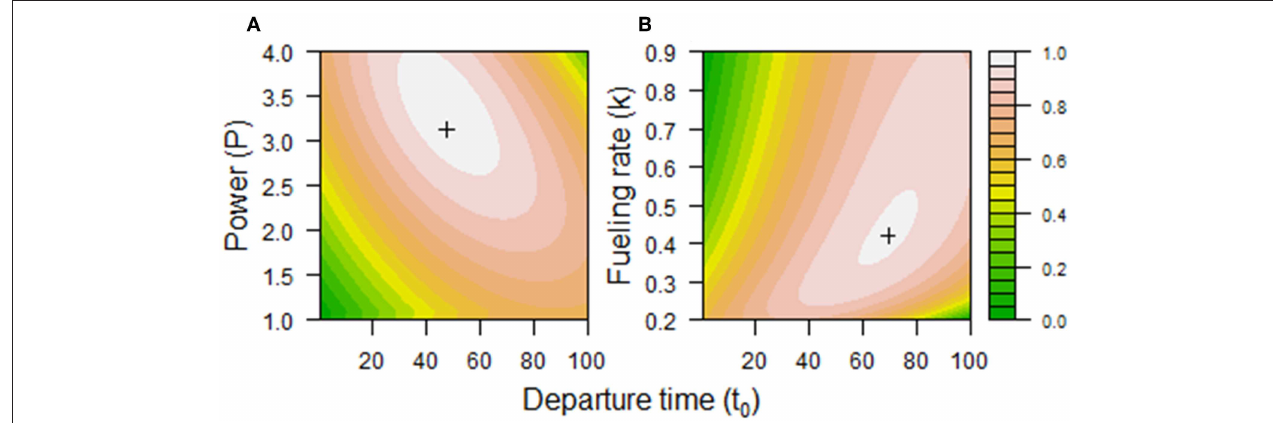
FIGURE 4 | Fitness associated with combinations of (A) departure time ( t 0 ) and power ( P ) or (B) departure time ( t 0 ) and fueling rate ( k ) using baseline parameter values in the migration model. Optimal combinations { t * 0 , P * } and { t * 0 , k * } are shown as crosses. In (A) , t * 0 = 48 days, P * = 3.1W, and t * 1 = 142 days. In (B) , t * 0 = 69 days, k * = 0.42W, and t *